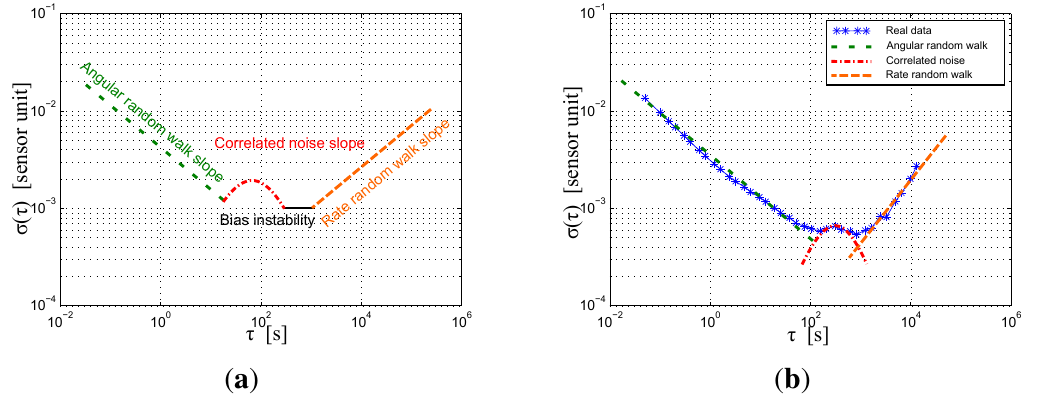
Figure 3. Allan variance sketch and its application to the considered IMU. ( a ) Sketch of the Allan variance process. Visible imperfections are described; ( b ) Application of the Allan variance on one accelerometer. Table 2. Numerical results for the standard deviation from the Allan variance applied to the simulation of a low-cost IMU [20]. Here, unit represents the unit of the sensor